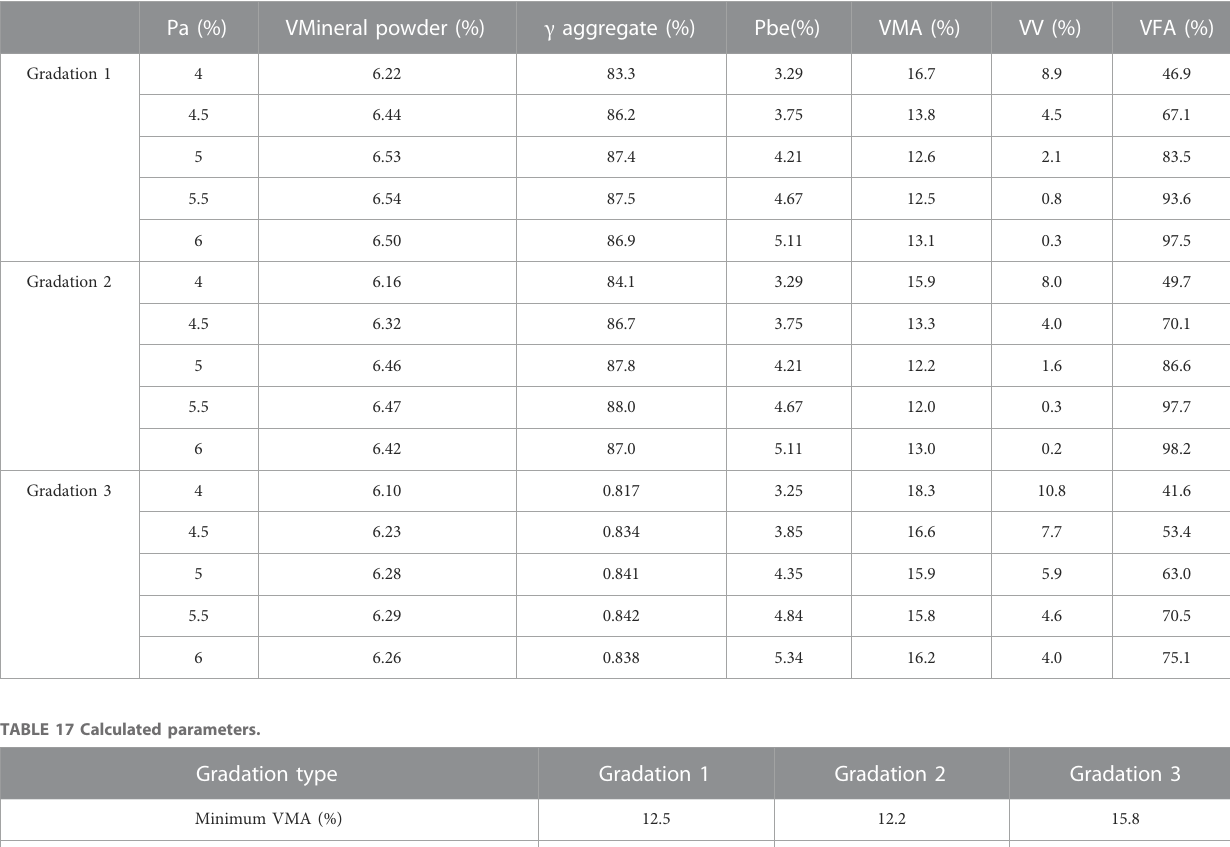
TABLE 16 Mixture parameters.